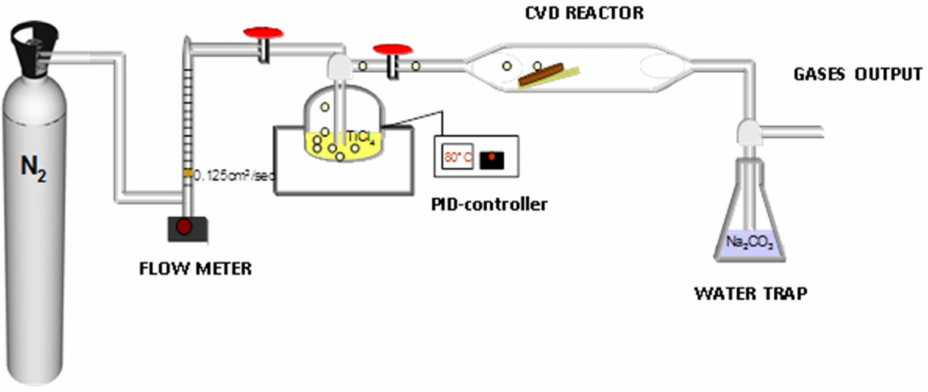
Figure 2. Schematic representation of the experimental CVD